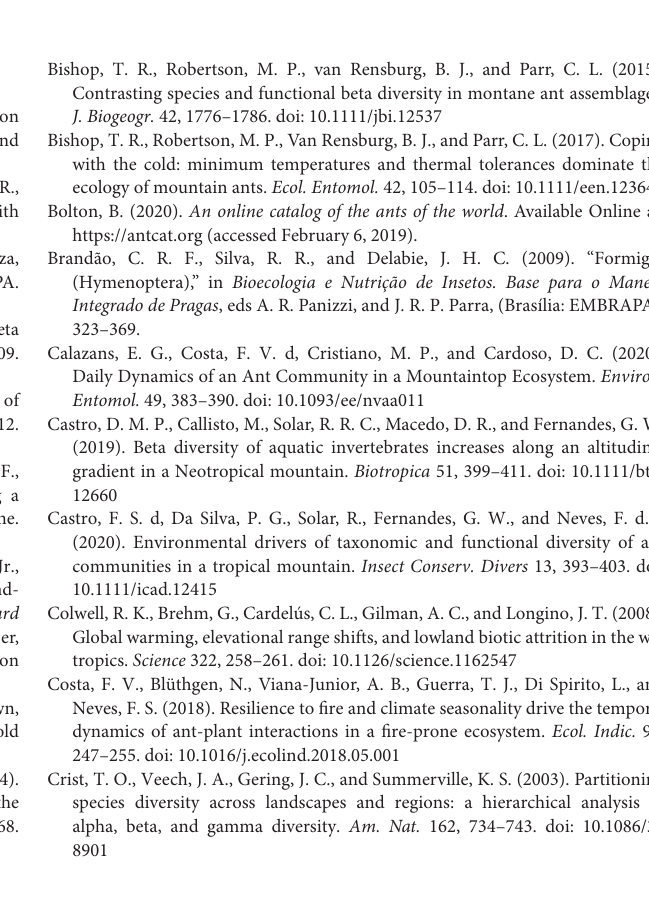
Supplementary Figure 1 | Community weighted mean (CWM) values of continuous traits of ant metacommunities during four periods of the year: the beginning and end of wet and dry seasons. Supplementary Table 1 | Correlations between environmental variables. Supplementary Table 2 | Functional traits and temporal data used in data